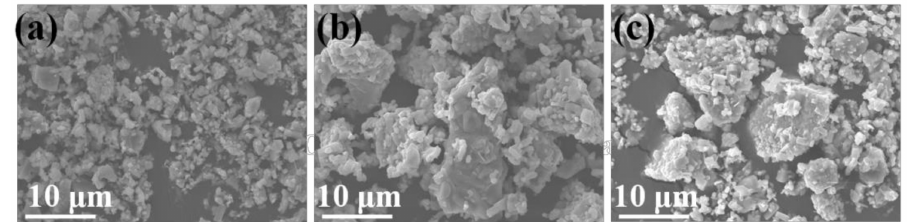
Figure 5. SEM images of different samples ( a ) roasted at 950 ◦ C for 1 h; ( b ) roasted at 1000 ◦ C for 1 h; ( c ) roasted at 950 ◦ C for 1.5 h.